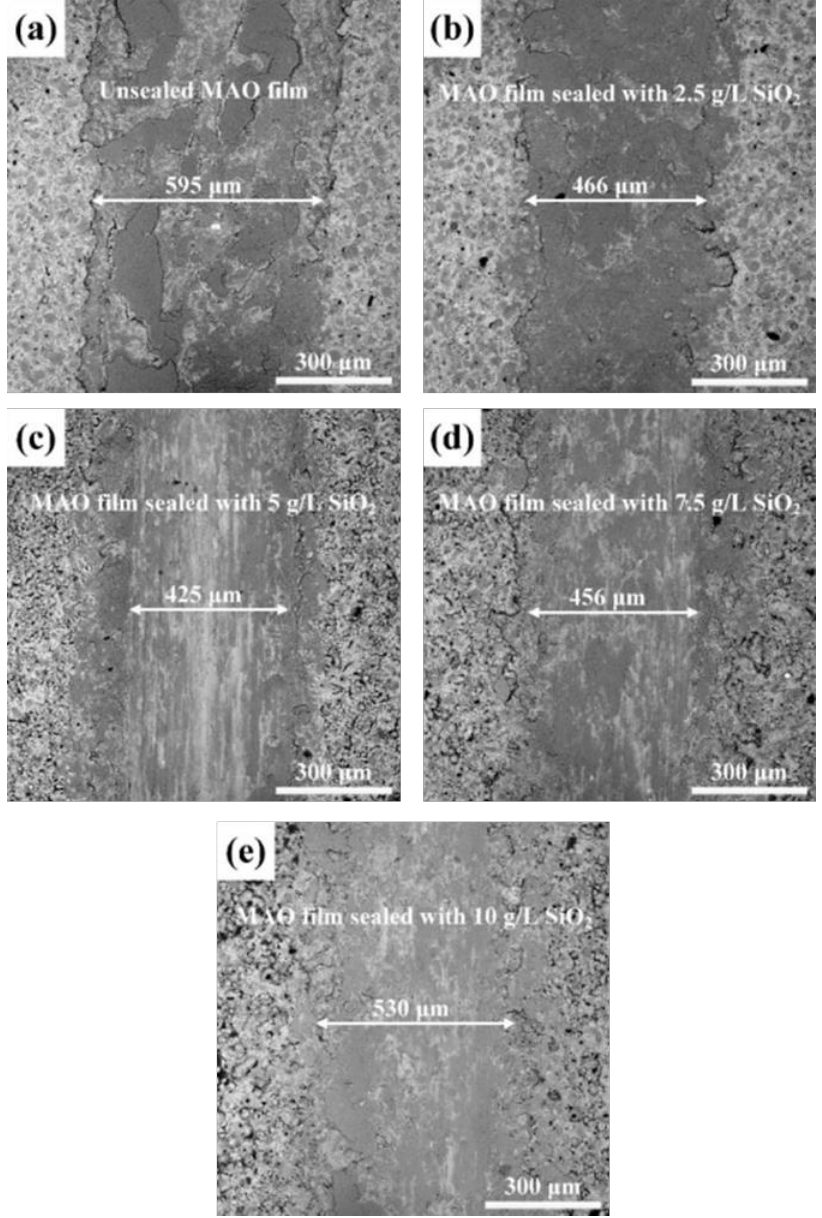
Figure 7. Wear track images of unsealed MAO film ( a ) and MAO films sealed by different concentrations of SiO 2 nanoparticles: ( b ) 2.5 g/L, ( c ) 5 g/L ( d ) 7.5 g/L and ( e ) 10 g/L.